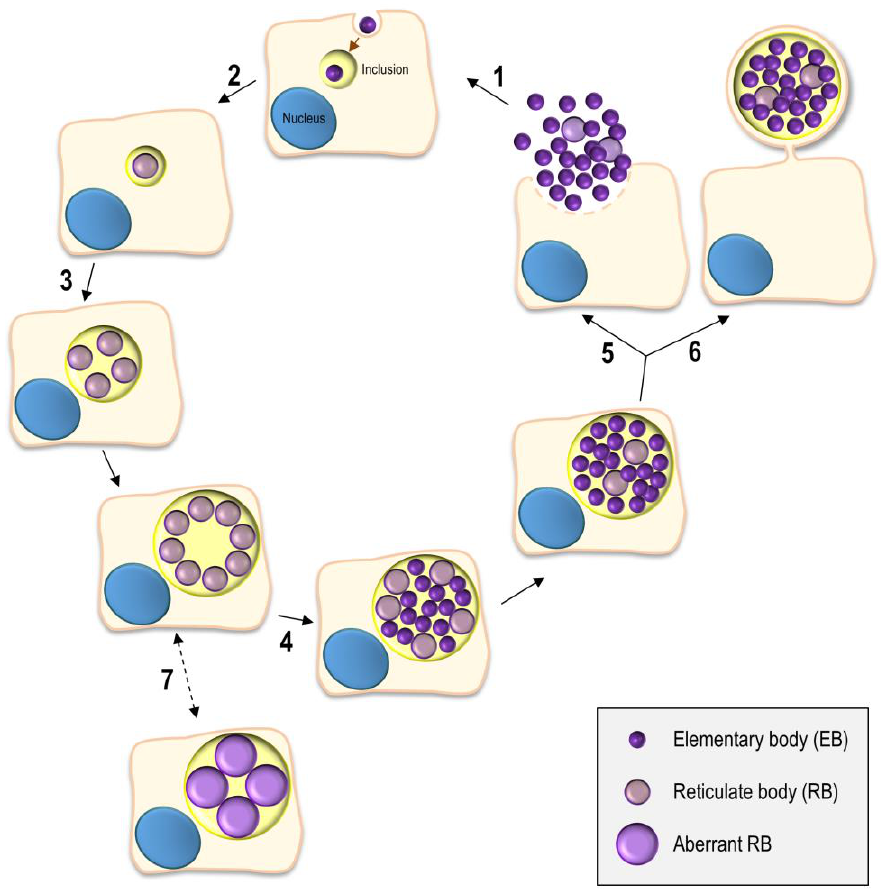
FIGURE 1: The chlamydial de- velopmental cycle. (1)